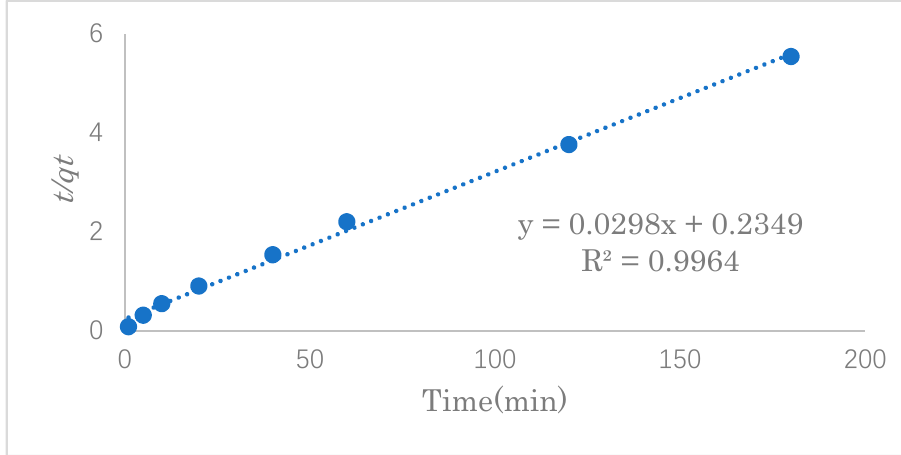
Figure 12. Pseudo-second-order plot of SDS adsorption by modified cellulose. Table 2. Isotherm parameters of SDS adsorption by the modified cellulose.